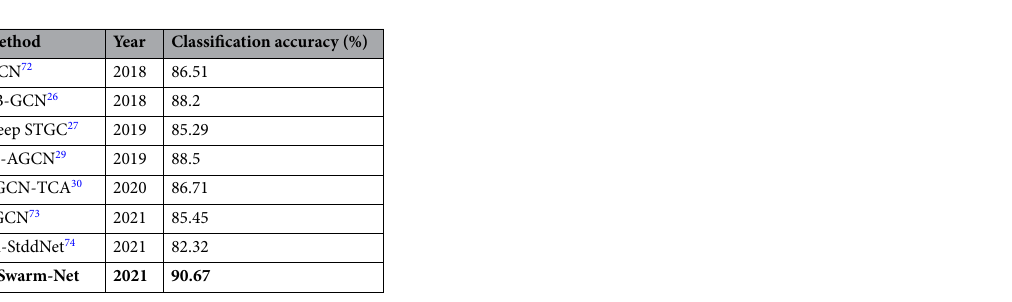
Table 7. Comparison of our proposed DSwarm-Net model with existing methods on the HDM05 dataset using 10 random split-mean protocol.